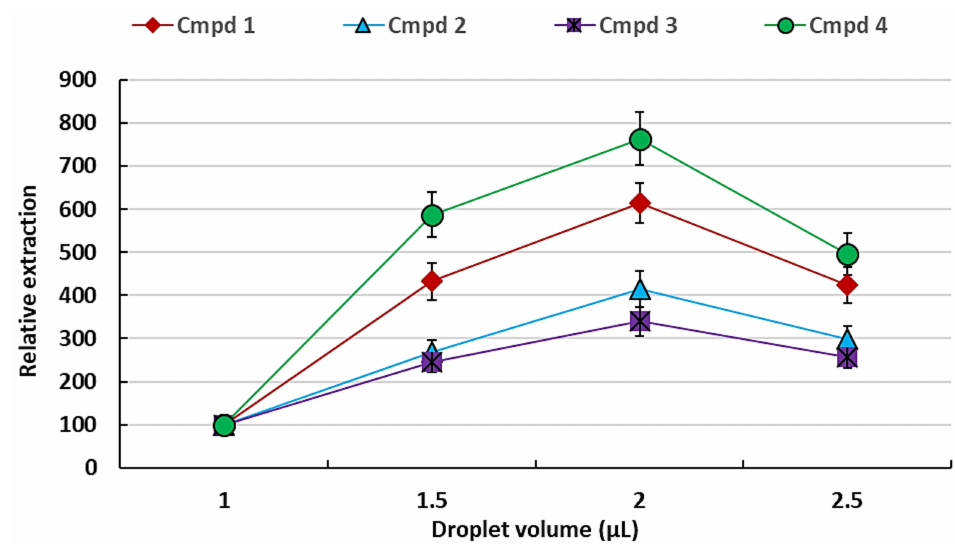
Figure 2. Effect of heptadecane droplet volume (relative to 1 µ L) on the extraction of VOCs following a 10 min equilibration time. The error bars indicate the standard deviation for n = 3 replicates.